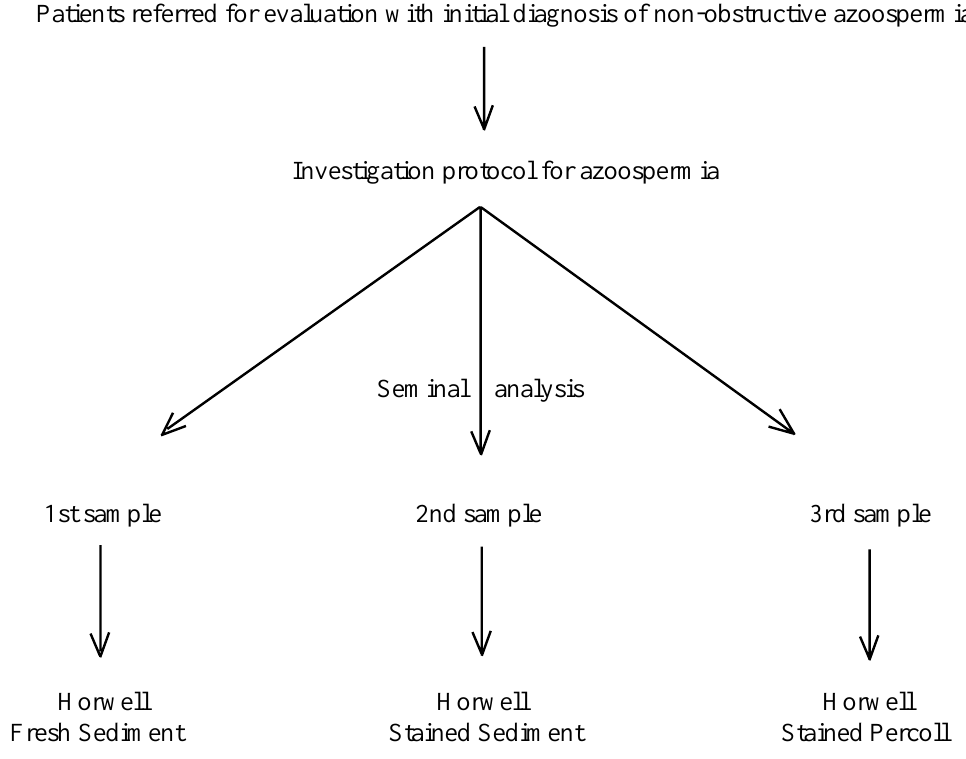
Figure 1 – Flow chart for investigation of non-obstrictive